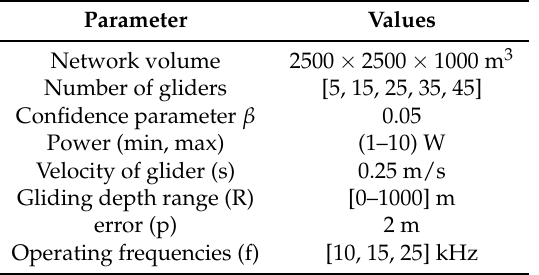
Table 4. Simulation parameters of the proposed